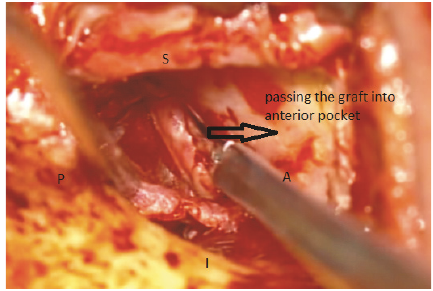
Figure 4: Passing the graft into the anterior pocket.